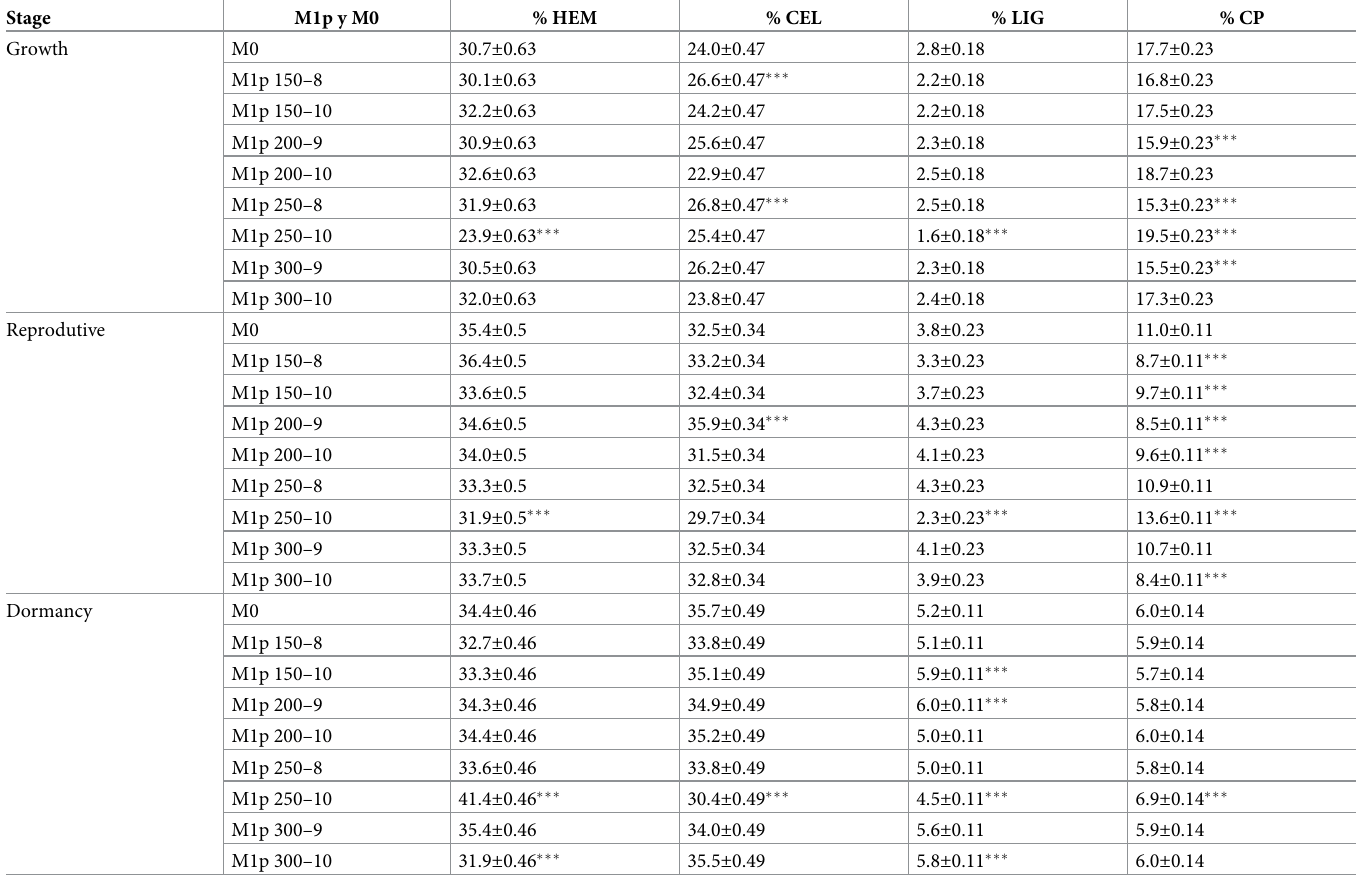
Table 2. Means ± standard error with the Dunnett test for content of structural fibers and crude protein by phenological stage in eight promising mutant genotypes (M1p) of natal grass [ Melinis repens (Willd.) Zizka], germinated from seed irradiated with Co 60 vs genotypes germinated from non-irradiated seed (M0). Stage Growth